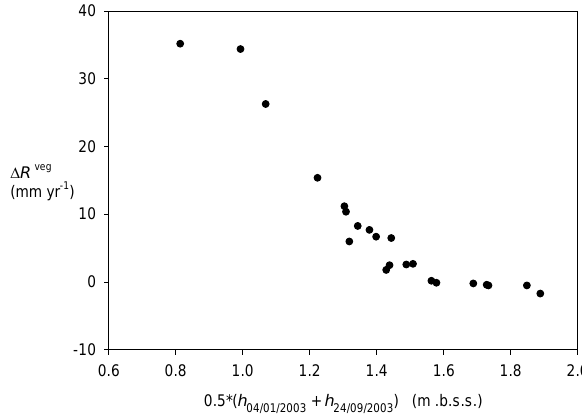
Figure 11. Simulated recharge R = ( P – ET a ) along the cross-section AB (Fig. 5), for the part 2 Fig. 11. Simulated recharge R =( P – ET a ) along the cross-section AB (Fig. 5) for the part that is in use by agriculture. This plot is for that is in use by agriculture. The plot is for the arable land scenarios, for the static/dynamic 3 the arable land scenarios, for the static/dynamic simulations, and for simulations, for the W + climate scenario. 4 the W + climate scenario.